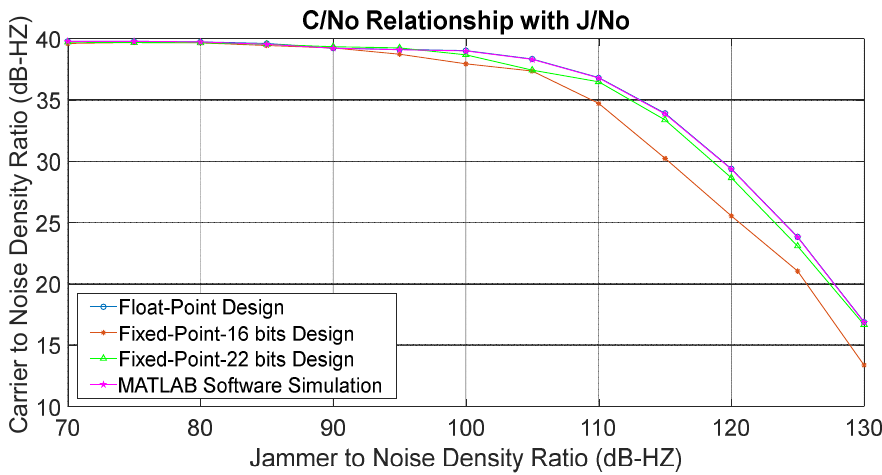
Figure 26. C/No versus J/No for the float-point design, fixed-point 16-bit design, fixed-point 22-bit design, and MATLAB simulation with a single CW jammer at J/No = 80 dB-Hz and freqj = 6.5033 MHz.